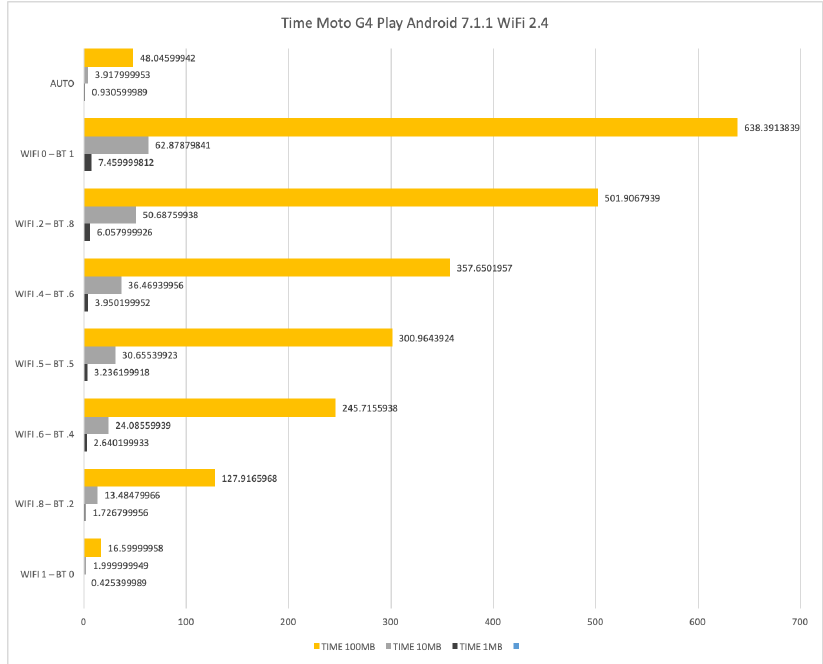
Figure 18. Time required for transferring files of size 1 Mb, 10 Mb and 100 Mb by means of WiFi at 2.4 GHz and Bluetooth on a Motorola G4 Play.